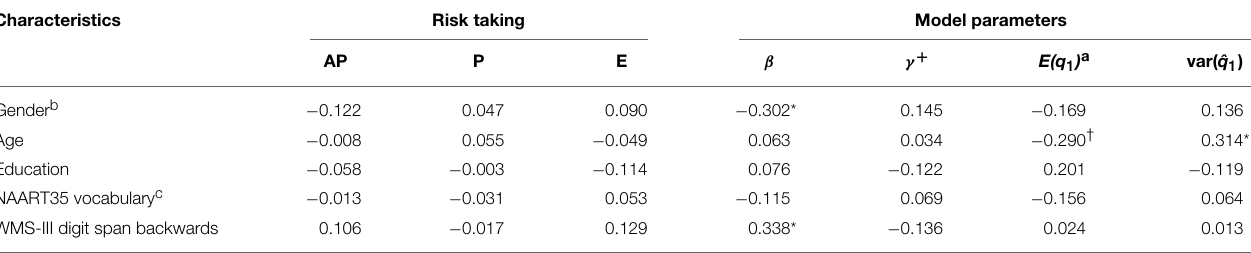
TABLE 2 | Correlations between individual characteristics, performance, and model parameters for the Balloon Analog Risk Task (BART) across both groups.